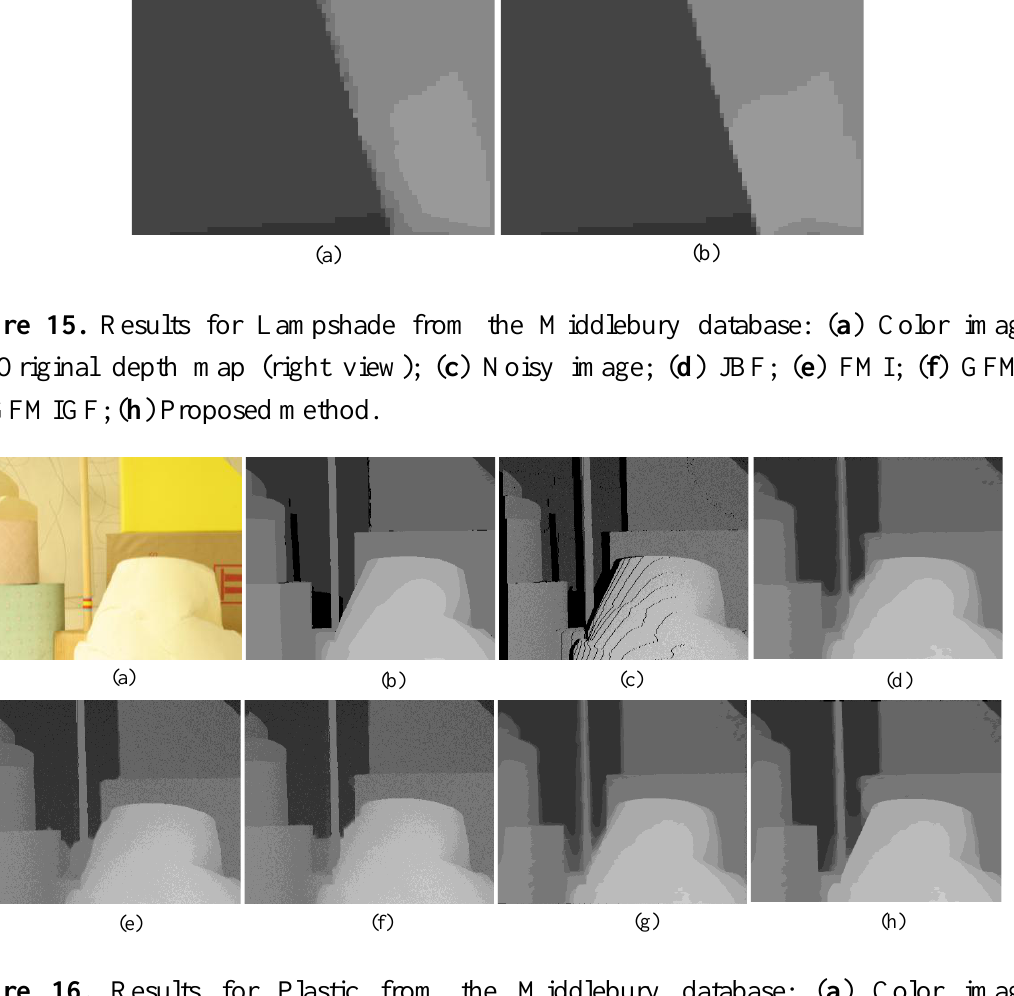
Figure 16. Results for Plastic from the Middlebury database: ( a ) Color image; ( b ) Original depth map (right view); ( c ) Noisy image; ( d ) JBF; ( e ) FMI; ( f ) GFMI; ( g ) GFMIGF; ( h ) Proposed